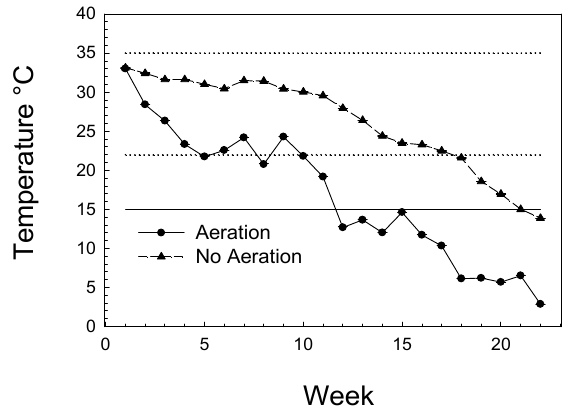
Figure 1. Mean temperature (°C) each week recorded at one m below the surface in aerated and non-aerated bins (N = 8 bins of each) for 22 weeks of the study; standard errors of the weekly means were not greater than 2 °C in any case and are not shown in the figure. Aeration began on 21 July and Week 1 mean temperatures were recorded on 1 August. Data are shown to week 22, which ended 16 January. Solid horizontal line at 15 °C is the minimum temperature for development of the species studies; dashed lines indicate their optimum development range of 22 °C to 35 °C.